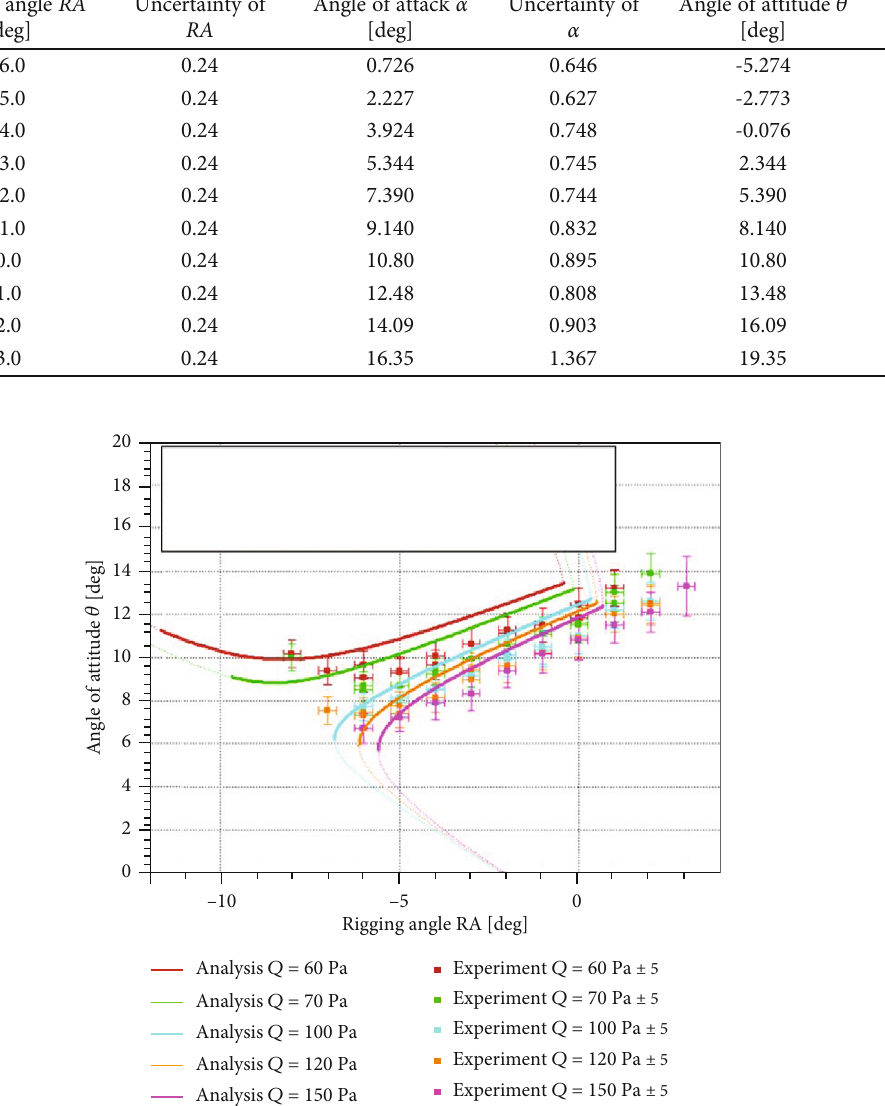
Figure 17: Analysis and experimental results of e ff ect of RA on parafoil attitude under di ff erent dynamic pressure environments.